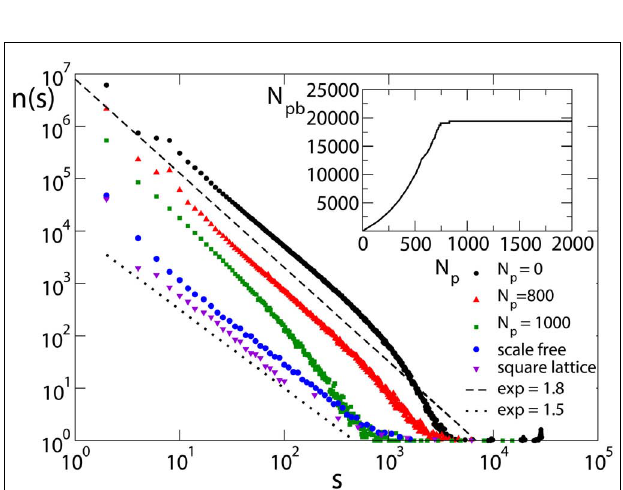
FIGURE 5 |Avalanche size distribution for different networks with p in = 0.05: the square lattice ( N = 10 6 , α = 0.03); the scale-free network ( N = 4000); and theApollonian network for different values of N p (9th generation with α = 0.030). Initial synaptic strengths are randomly distributed. Data are logarithmically binned. In the inset, the corresponding behavior of the number of pruned bonds for the Apollonian network is shown.